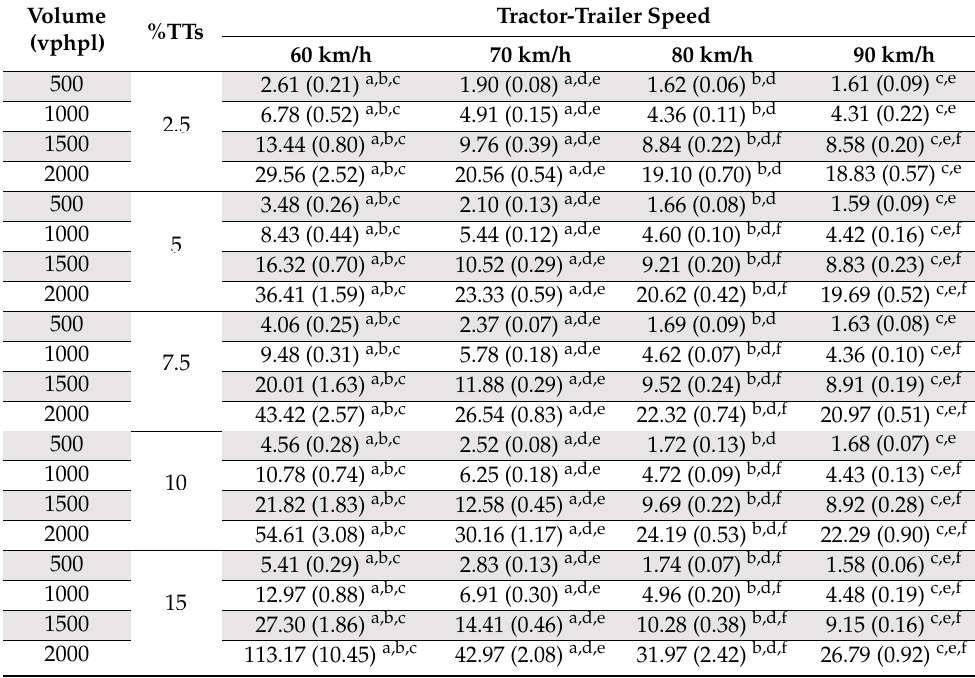
Table 3. Delay (in sec/vehicle) results for speed limit of 90